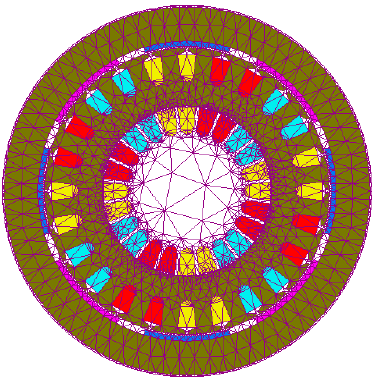
Figure 5. The finite-element models (FEMs) of N-TWDDPMSM.